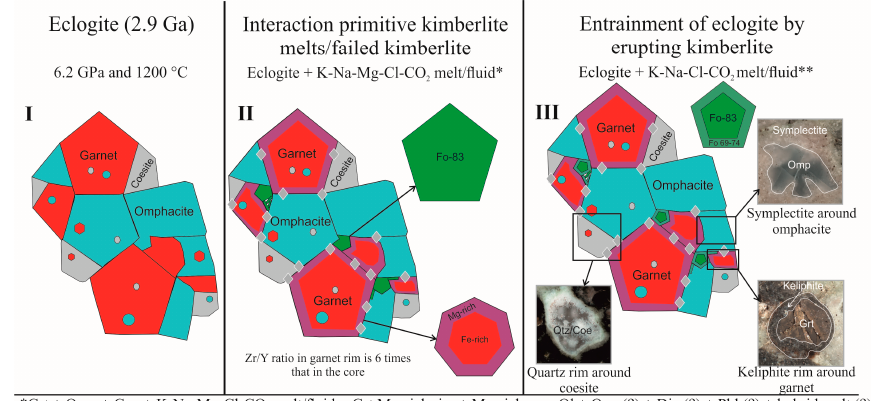
Figure 9. Cartoon illustrating the pre-kimberlite magmatism history of xenolith Uv-537 and processes involved in its multi-stage evolution (note that depicted mineral volumes are approximate and not designed to represent fluxes). I : Formation of coesite-bearing eclogite (~2.9 Ga) and ancient metasomatic event; II : interaction of eclogite with a metasomatizing carbonatitic or alkali carbonatitic melt (precursory of kimberlite magmatism) produces Mg-rich cores in olivine (Ol, Fo—forsterite number) and Mg-rich rims on garnet (Grt). Omp—omphacite; Coe—coesite;